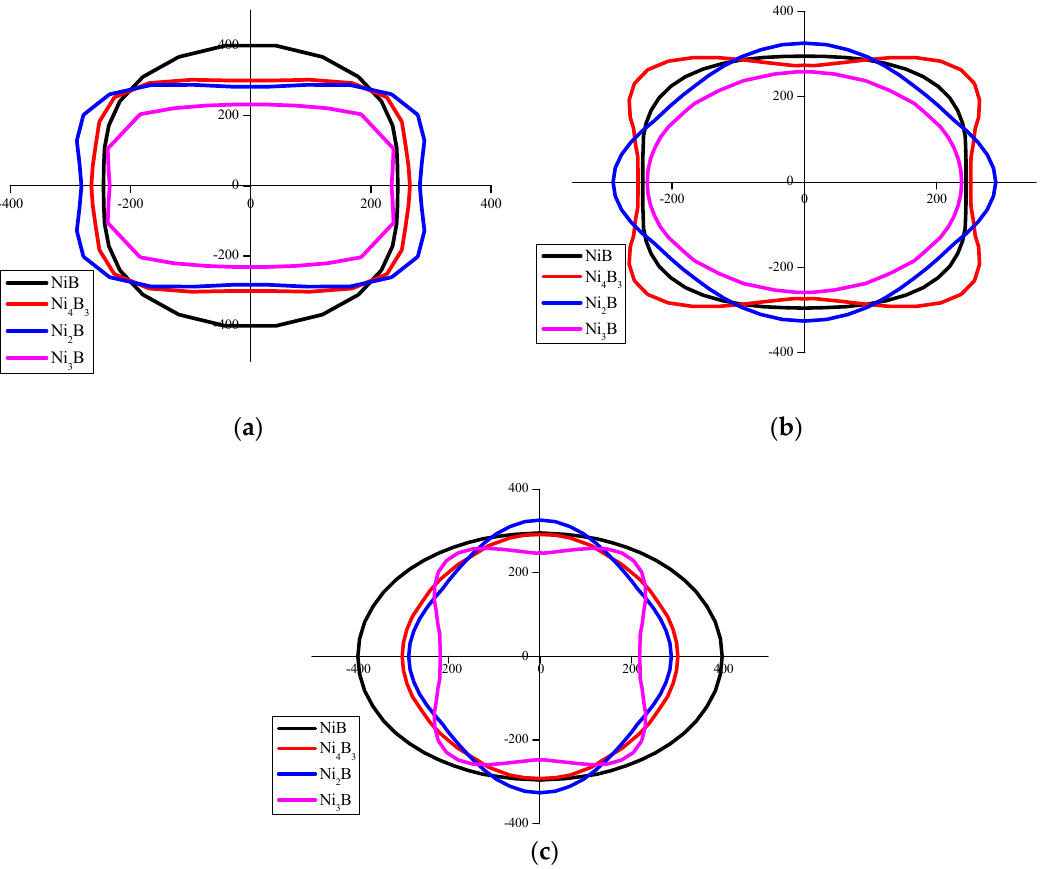
Figure 3. Planar projections of the Young’s modulus of Ni x B y compounds ( a ) (X-Y) planar; ( b ) (X-Z) planar; ( c ) (Y-Z)